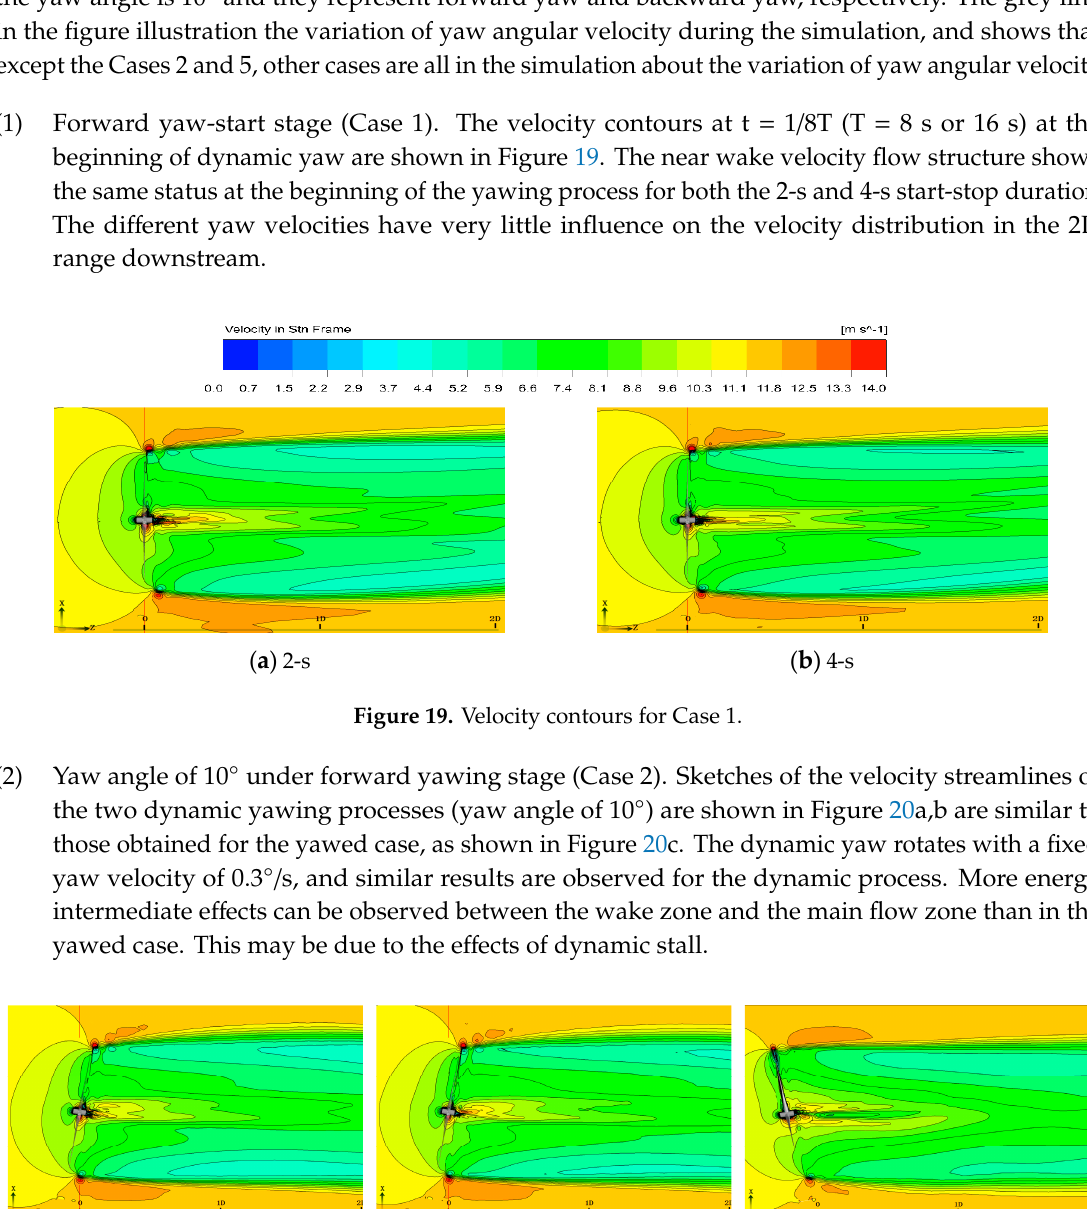
Figure 18. Six cases during the start-stop stage under dynamic yaw.